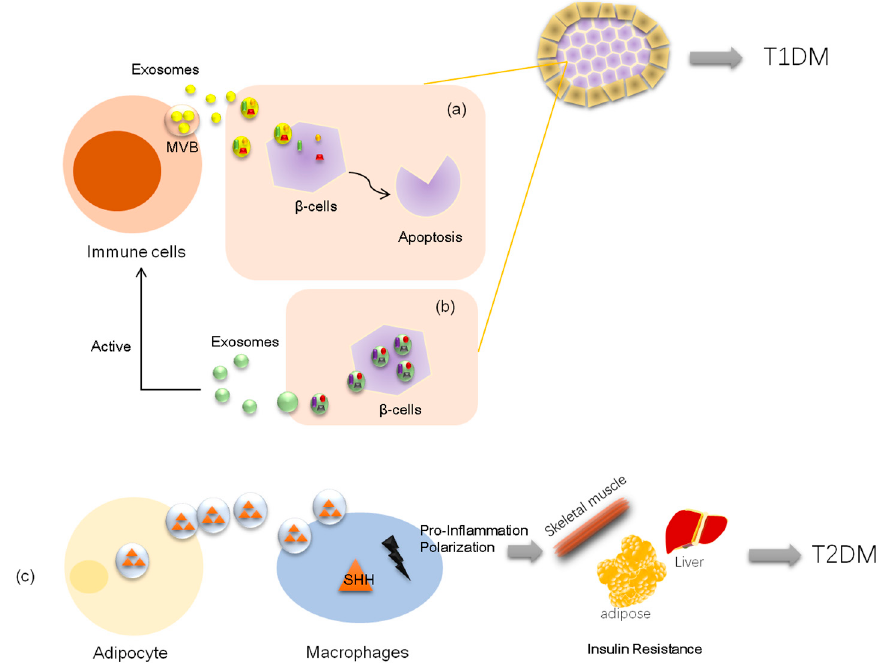
Figure 2. Exosomes regulate diabetic pathological process. Schematic representation of exosomes participating in the pathologies of type 1 diabetes (T1D) and type 2 diabetes (T2D). ( a ) Immune cell-derived exosomes can activate immune cells and induce β -cell apoptosis and cell death. ( b ) In certain models, pancreatic islets also release intracellular β -cell autoantigens in exosomes in turn to favor the immune response. ( c ) Adipocyte-derived exosomes carrying sonic hedgehog (SHH), a protein known to modulate immunity, induce proinflammatory or M1 polarization of bone marrow-derived macrophages and induce insulin resistance in the main insulin-sensitive organs (skeletal muscle, liver, adipose).